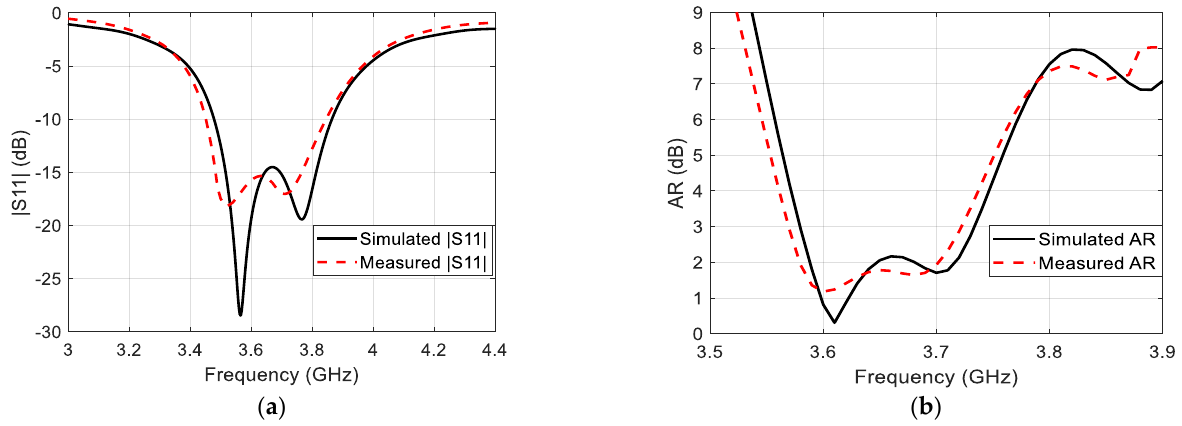
Figure 8. Simulation and measured ( a ) reflection coefficient and ( b ) AR of the proposed single-element circularly polarized microstrip antenna.